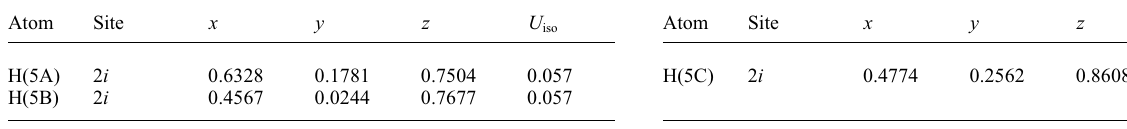
Table 3. Atomic coordinates and displacement parameters (in Å 2 )